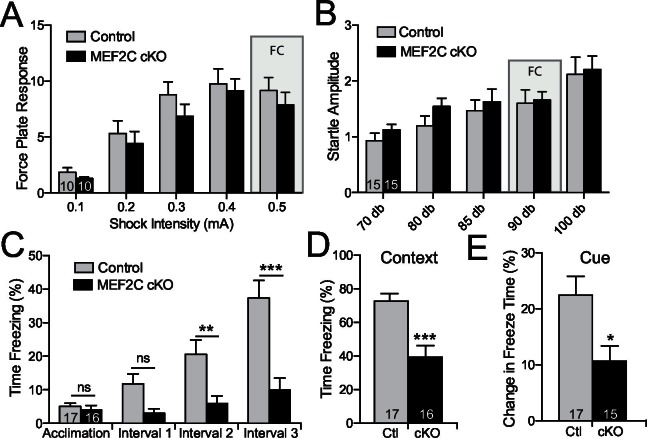
Cognitive deficits in Mef2c cKO mice.(A–B) Both control and Mef2c cKO mice showed similar force plate response to various intensities of shock (A) or acoustic startle (B). Grey bars highlight the intensities used in fear conditioning (FC). (C) During training for fear conditioning, Mef2c cKO mice fail to increase freezing during the 1-minute intervals after each tone/shock pairing. (D) Fear Conditioning. Mef2c cKO mice show deficits in contextual memory. (E) Fear Conditioning. In a novel context, Mef2c cKO mice show deficits in cue-dependent memory. Data are represented as mean ± SEM. Statistical significance was determined by 2-way ANOVA (A–C) or unpaired t-test (D,E). *p<0.05, **p<0.005, ***p<0.0005, ns=not significant. Numbers of animals (n) are reported in each bar for respective experiment.